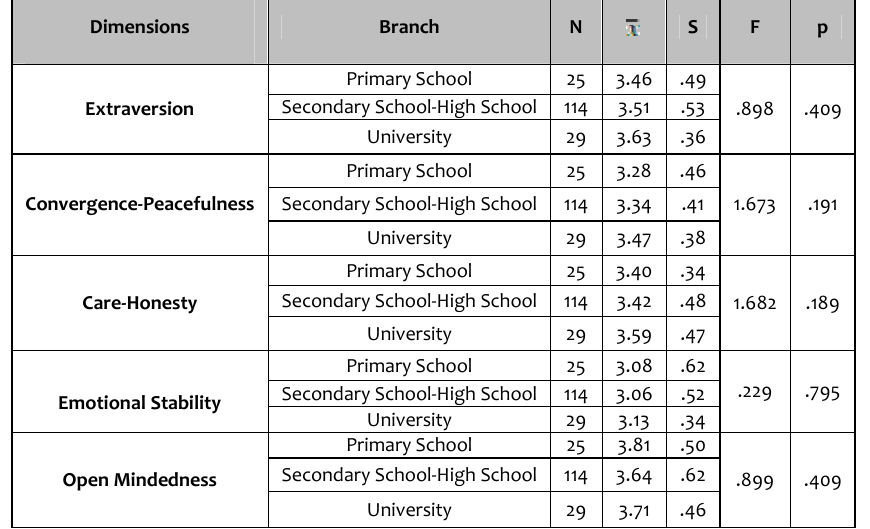
Table 3. Anova Test for Differentiation of Personality Traits Scores Average of the Visually Impaired Athletes who participated in the study according to Education Level Dimensions